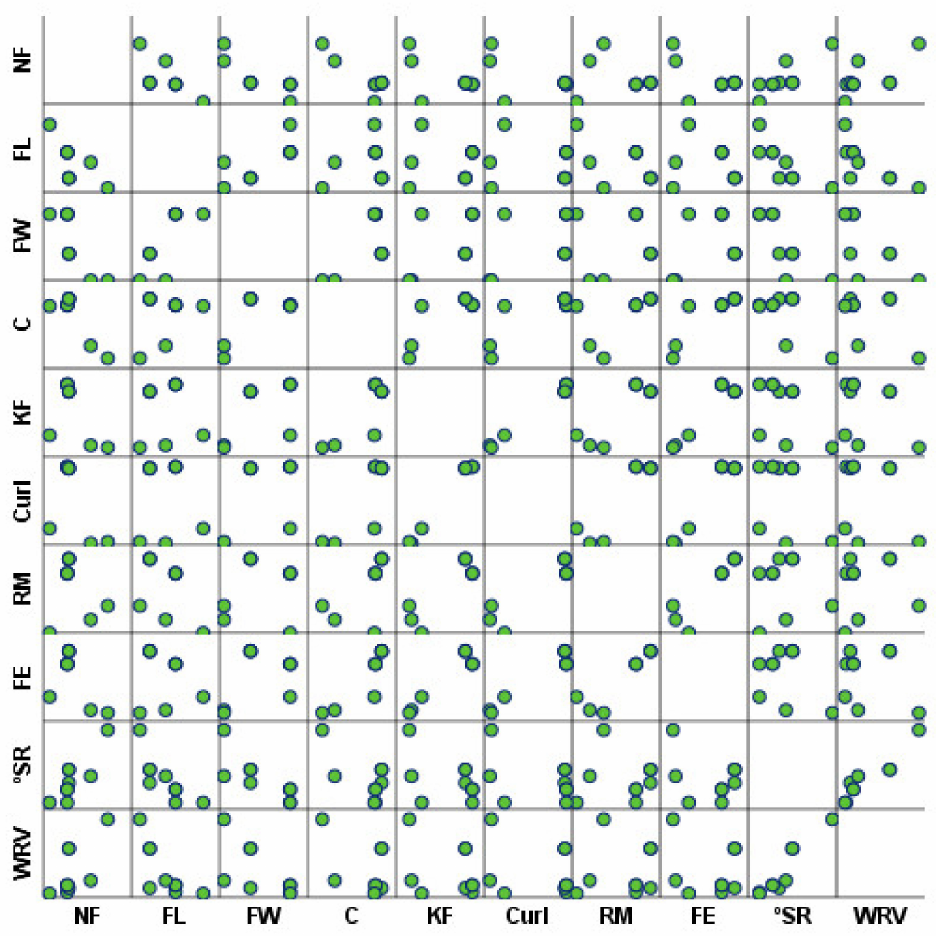
Figure 8. Correlation matrix of fiber morphology and water interaction